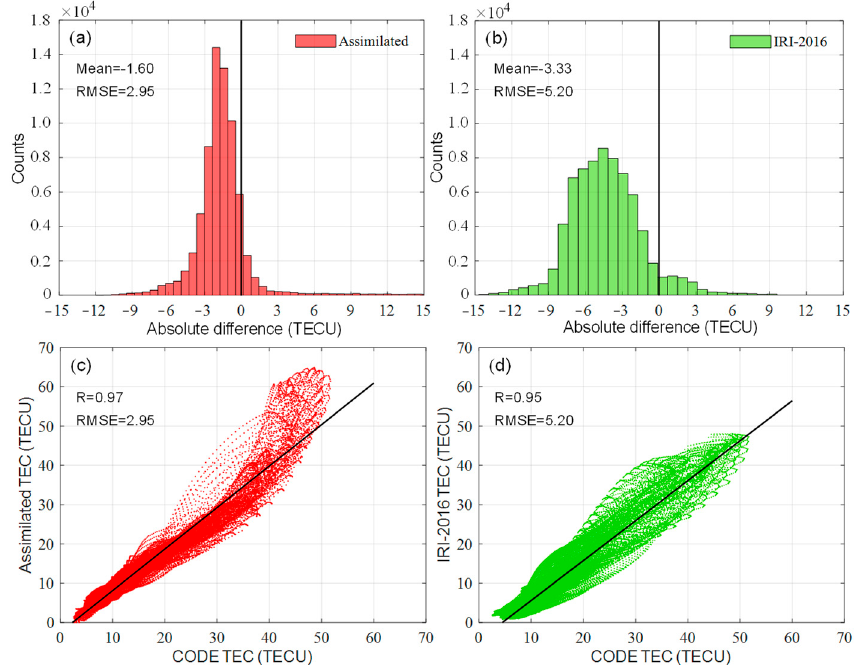
Figure 4. Distributions of absolute differences and TEC correlations on 6 September 2017. ( a ) Absolute differences between the assimilated TEC and the CODE TEC; ( b ) Absolute differences between the IRI-2016 TEC and the CODE TEC; ( c ) Assimilated TEC distribution versus the CODE TEC; ( d ) IRI-2016 TEC distribution versus the CODE TEC.